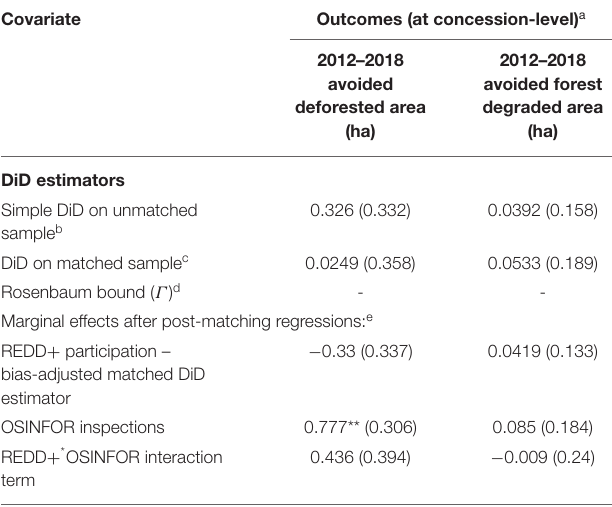
TABLE 3 | Singular and combined effects of the Madre de Dios REDD + project and OSINFOR inspections on land-cover changes, 2012–2018.